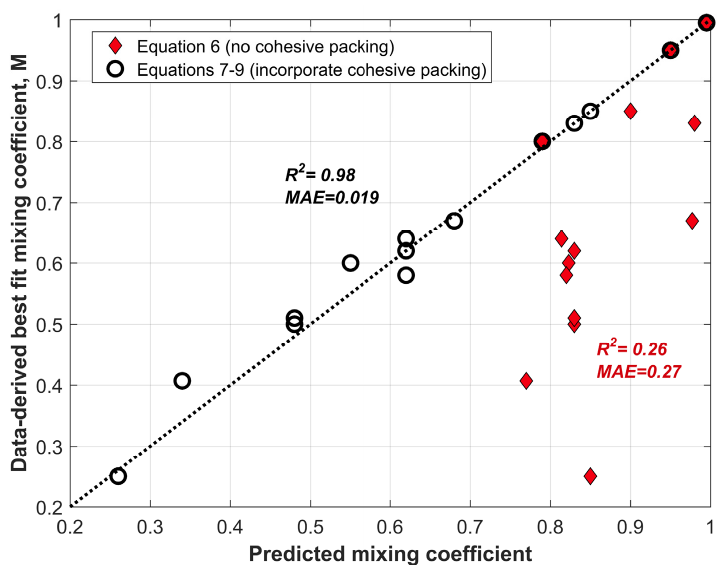
Figure 4. Comparison between the data-derived best fit mixing coefficient M, and the predicted values for mixtures involving cohesive fines (clay or fine silt). Predictions were done using two different approaches: without incorporating cohesive packing ( red diamonds ), versus incorporating cohesive packing ( black circles ). The correlation coefficient ( R 2 ) and mean absolute error ( MAE ) for each approach are shown in red and black color.